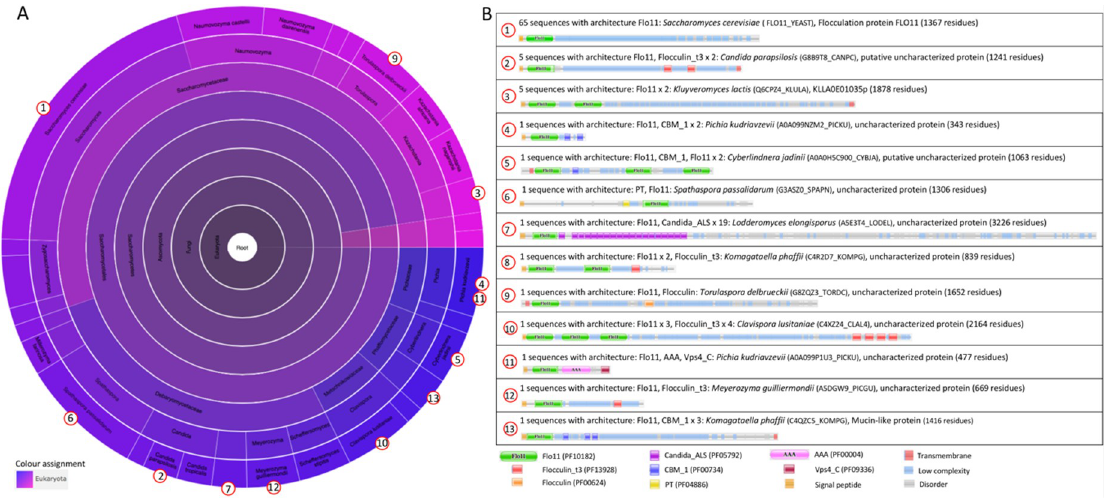
Figure 2. The family Flo11 (PF10182). A. Sunburst phylogenetic representation of the Flo11 domain family. B. Currently (July 2018), the Flo11 domain is present in 13 architectures and only within the family.